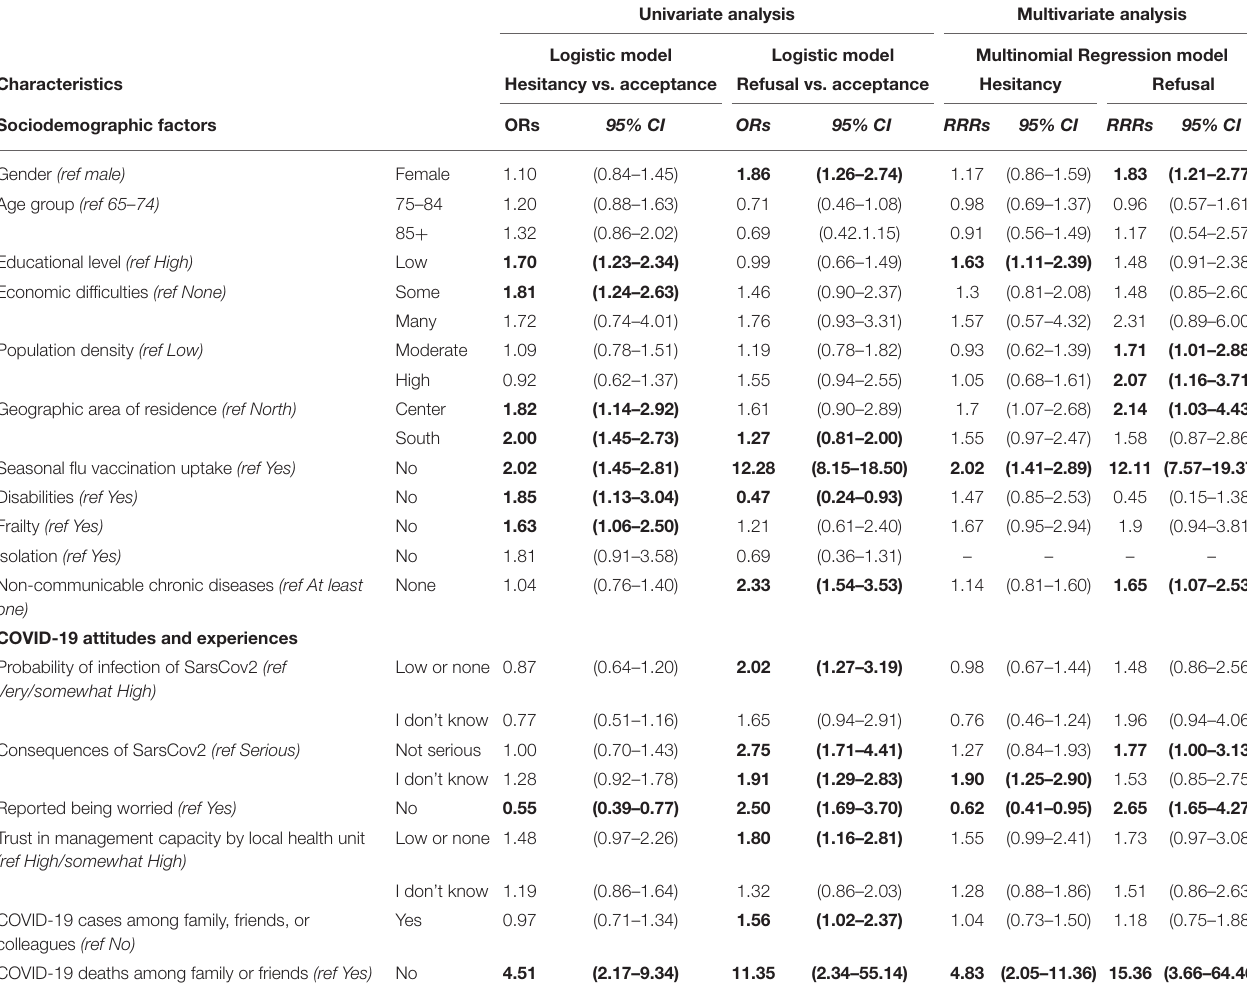
TABLE 2 | Association between Sociodemographic and COVID-related risk factors and hesitancy or refusal to accept the COVID-19 vaccine among Italian elderly. Univariate analysis Multivariate analysis Logistic model Logistic model Multinomial Regression